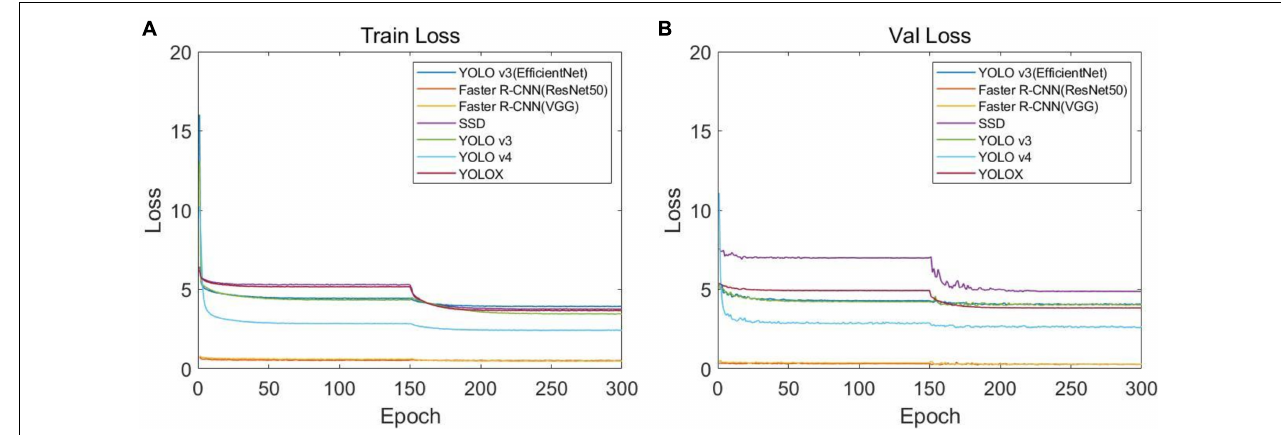
FIGURE 7 | Loss function curves of different networks: (A) loss function curve of the training set and (B) loss function curve of the verification